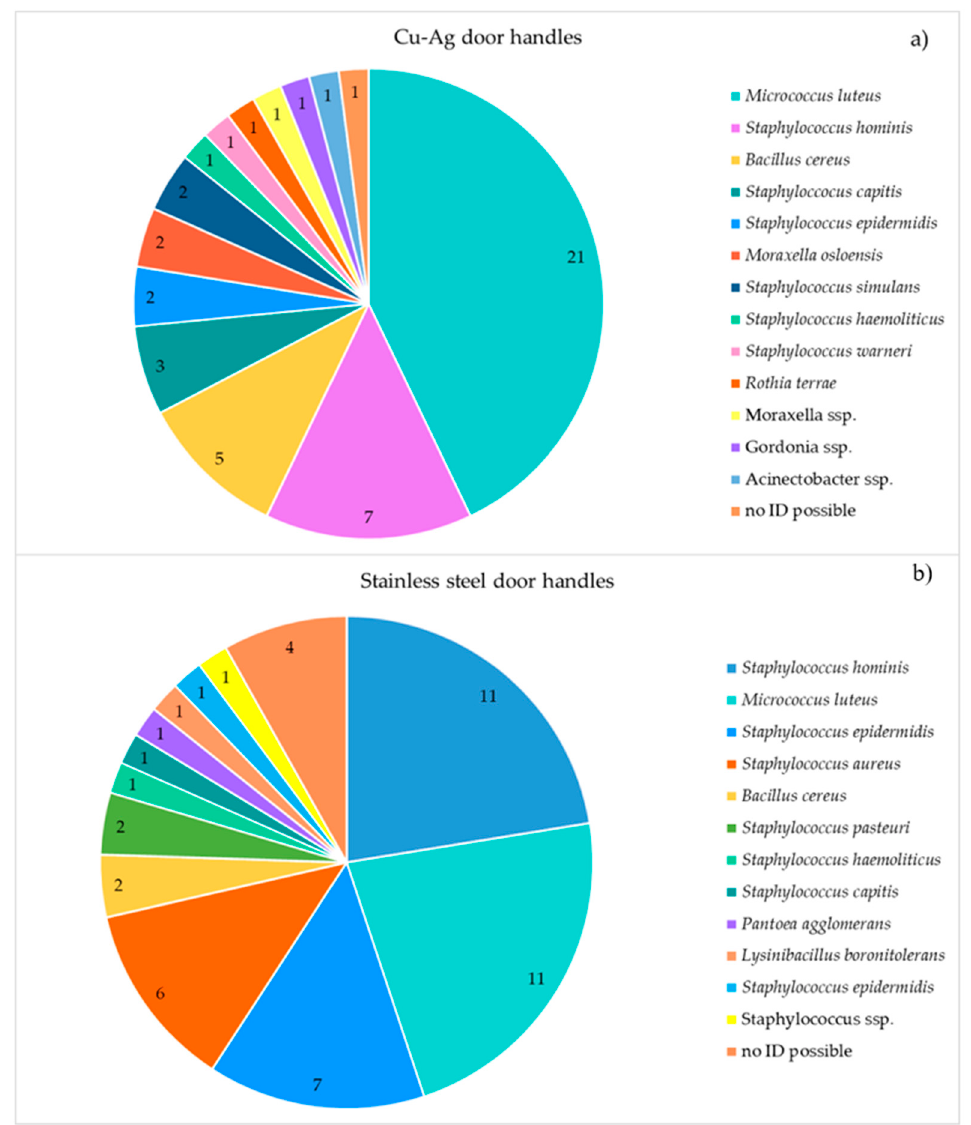
Figure 2. Species abundance of 98 microbial isolates recovered from copper-silver alloy coated ( a ) and uncoated stainless steel ( b ) door handles at FamilieLægerne Espergærde. Identification was performed with MALDI-TOF MS. The species are ordered according to their abundance in the column stacks and correspondingly in the legend. Identification at the species level was not possible for Bacillus ssp. and score values below 2.00, thus the genus is reported. It was not possible to recover and identify one isolate from stainless steel door handle due to lack of growth.